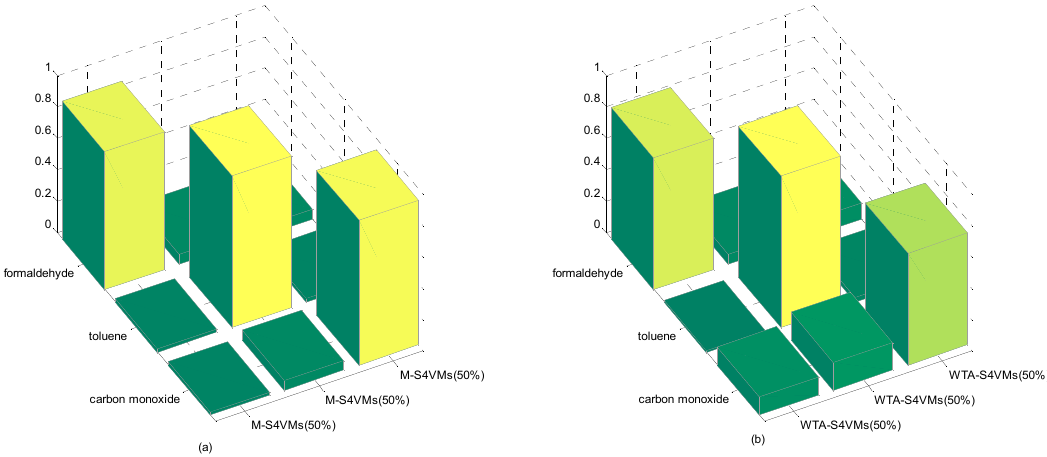
Figure 3. Total accuracy rate of the two algorithms with different unlabeled rates. It illustrates the total classification results for these three target gases by M-S4VMs and WTA-S4VMs when the unlabeled data account for 50% ( a ), 25% ( b ) and 75% ( c ), respectively. And it obvious that no matter what unlabeled rate it is, M-S4VMs always performs better than WTA-S4VMs. Sensors 2016 , 16 , 1462